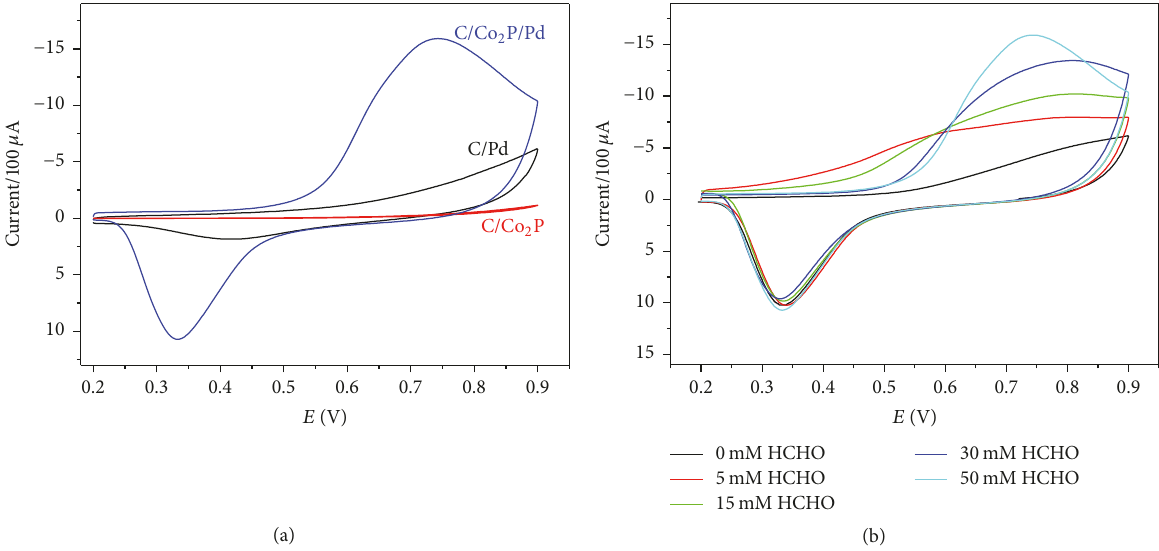
Figure 7: (a) CVs of the different electrodes in 0.5 M H 2 SO 4 solution containing 50mM formaldehyde from 0.2 V to 0.9 V at 50 mV/s. (b) CVs of the C/Co 2 P/Pd/GCE in 0.5 M H 2 SO 4 solution with different concentration of formaldehyde from 0.2 V to 0.9V at scan rate of 50